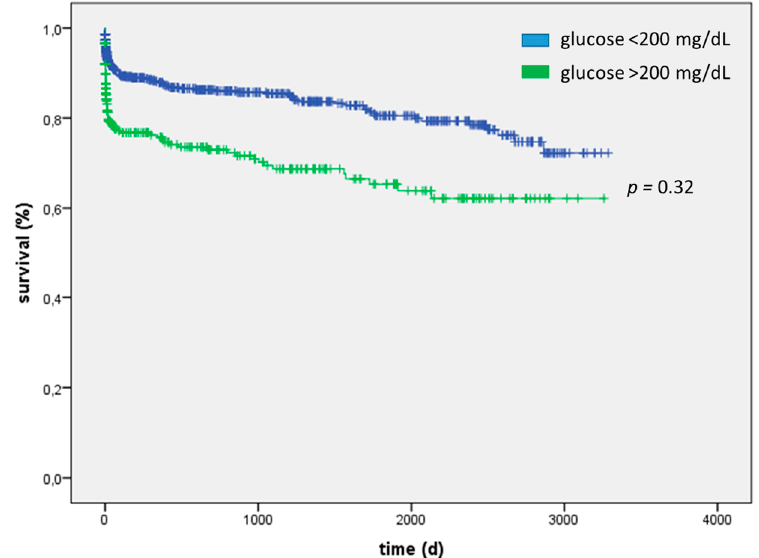
Figure 2. Patients admitted for sepsis and suffering from severe hyperglycemia did not evidence increased mortality in the long-term (HR 1.13, 95% CI: 0.89–1.44; p = 0.32). Table 5. Patients admitted for sepsis and suffering from severe hyperglycemia (>200 mg/dL) were of equal age (68 (55–76) vs. 68 (59–77) years; p = 0.21) and SAPS2 scores did not differ (52 ± 20 vs. 55 ± 20; p = 0.25).